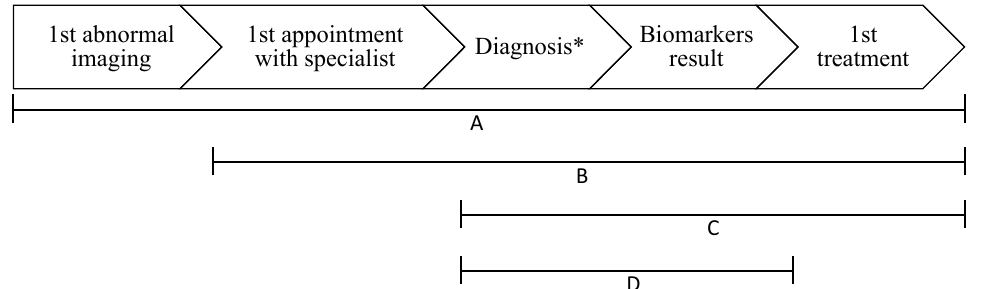
Figure 1. Diagnosis and treatment time intervals. * Defined as the date of the pathology result. A = 1st abnormal imaging to 1st treatment; B = 1st appointment with specialist to 1st treatment. C = diagnosis to 1st treatment (including surgery, definitive radiation, definitive chemoradiation, and systemic treatment); D = pathology result to biomarkers result. A fifth interval, radiation referral to radiation, is not displayed on this figure.